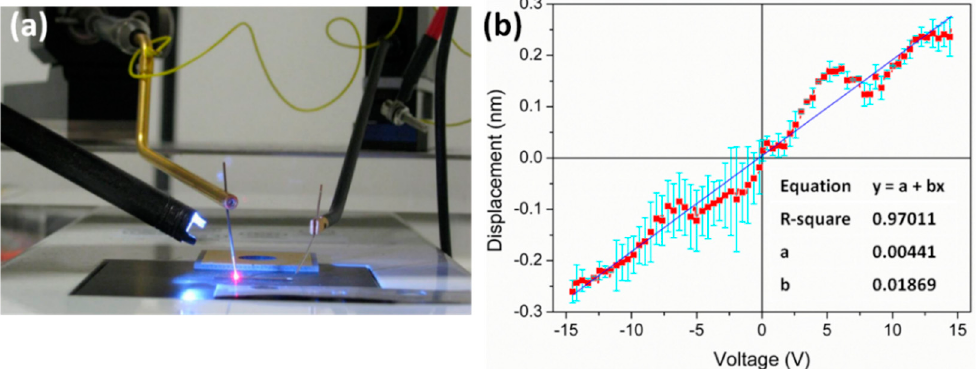
Figure 8. ( a ) Picture of the PES setup used for piezoelectric characterization. ( b ) Mechanical displacement vs. applied voltage measured on the PPT prototypes.